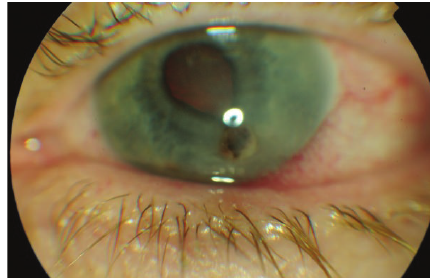
Figure 1: Perforated corneal ulcer plugged by the iris.